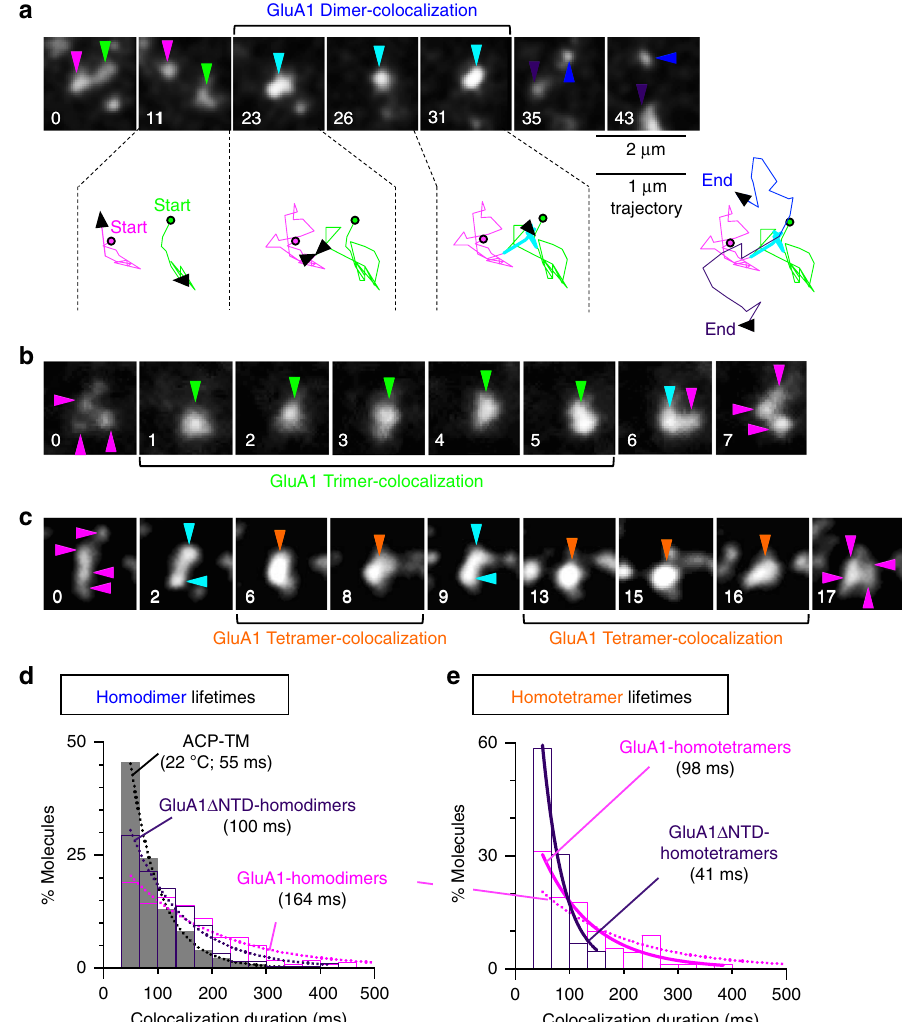
Fig. 3 GluA1 monomers form metastable homooligomers with exponential lifetimes of <200 ms, and dissociate into monomers. Typical single-molecule fl uorescence image sequences of two, three, and four diffusing ACP-GluA1 molecules undergoing transient dimerization, trimerization, and tetramerization in the HEK293-cell PM (from 236, 54, and 90 independent movies; a , b , and c , respectively). In the image sequence in a , two ACP-GluA1 molecules (green and magenta arrowheads) became colocalized in frame 23 (33 ms per frame, normal video rate) and diffused together for the next eight frames (for a 0.30-s total colocalization time; light blue arrowheads), until they became separated and diffused independently (blue and purple arrowheads). Colors of the subtrajectories are the same as those for the arrowheads (the circle and arrow show the locations at the start and at the time in the frame number on top, respectively). Since these experiments were conducted with a single color (ATTO594), after the dimerization event, which molecule corresponds to each one before dimer formation could not be determined (hence, different colors in the trajectory). b , c The spots with the intensities of monomers, dimers, trimers, and tetramers are indicated by magenta, blue, green, and orange arrowheads. d The distributions of the homodimer durations for ACP- GluA1, ACP-GluA1 Δ NTD, and ACP-TM, obtained by measuring the durations of all of the observed homo-dimerization events. The distribution for ACP- TM was obtained at 22 °C, a temperature at which ACP-TM ’ s diffusion coef fi cient becomes practically the same as those of ACP-GluA1 and ACP- GluA1 Δ NTD observed at 37 °C. Each histogram could be fi tted well with a single exponential decay function (dotted curves), providing the dimer lifetime (given in parentheses after correction for the photobleaching lifetime of the fl uorescent probe). Related data for Halo7-GluA1 and Halo7-TM are shown in Supplementary Fig. 5b. e The distributions of the homotetramer durations of ACP-GluA1 and ACP-GluA1 Δ NTD. Each histogram could be fi tted well with a single exponential decay function (solid curves), providing the tetramer lifetime (dotted curves for GluA1 homodimers). For statistical parameters, see Supplementary Table 4. Related GluA2 results are shown in Supplementary Fig.